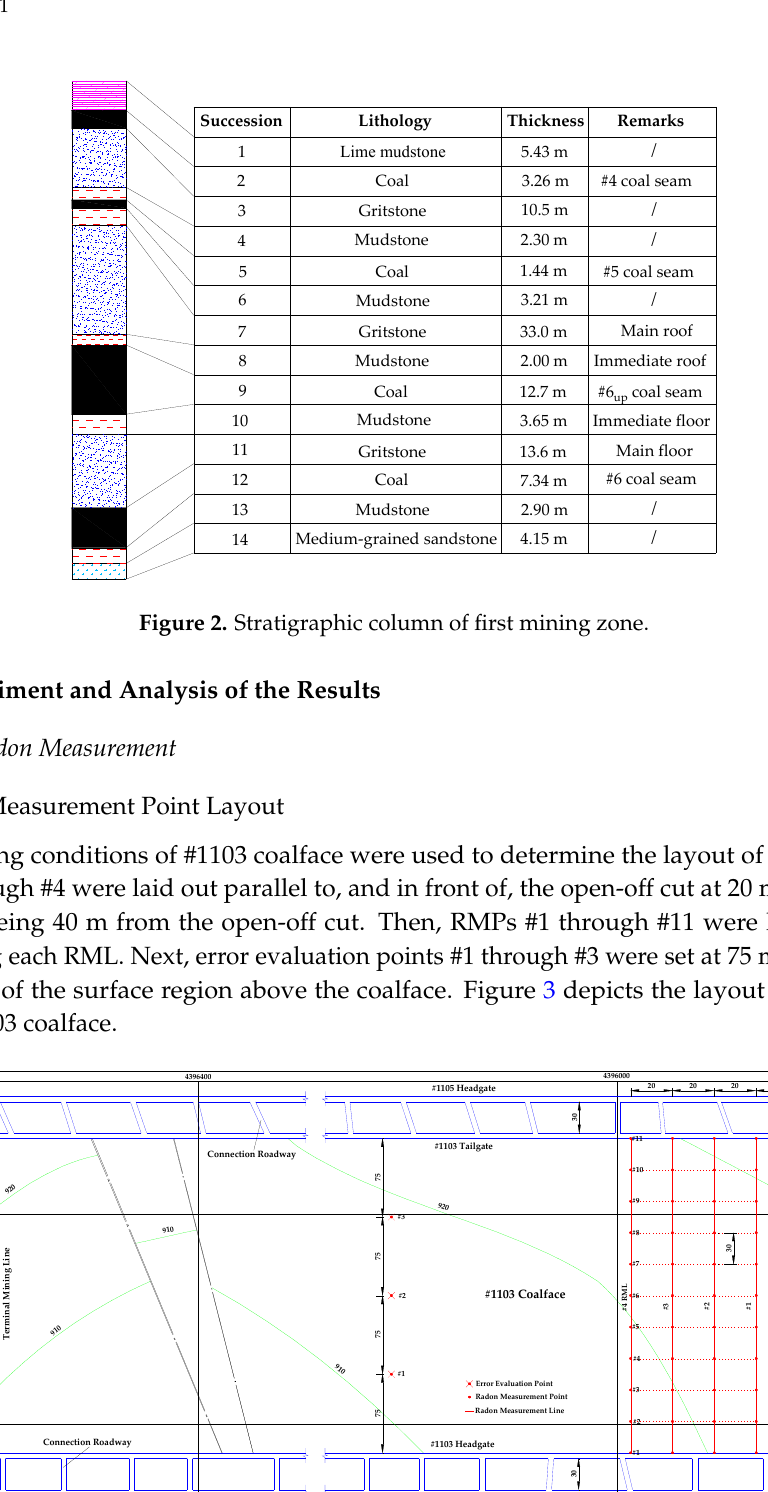
Figure 3. Layout of radon measurement points (RMPs) on the surface of #1103 coalface.